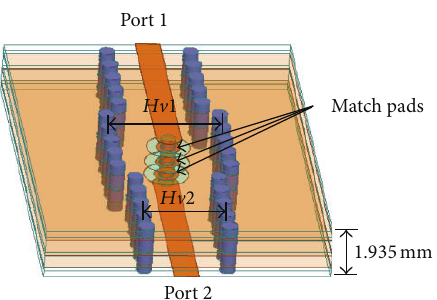
Figure 2: The 3D structure of the matching pads loaded MS-to-MS via